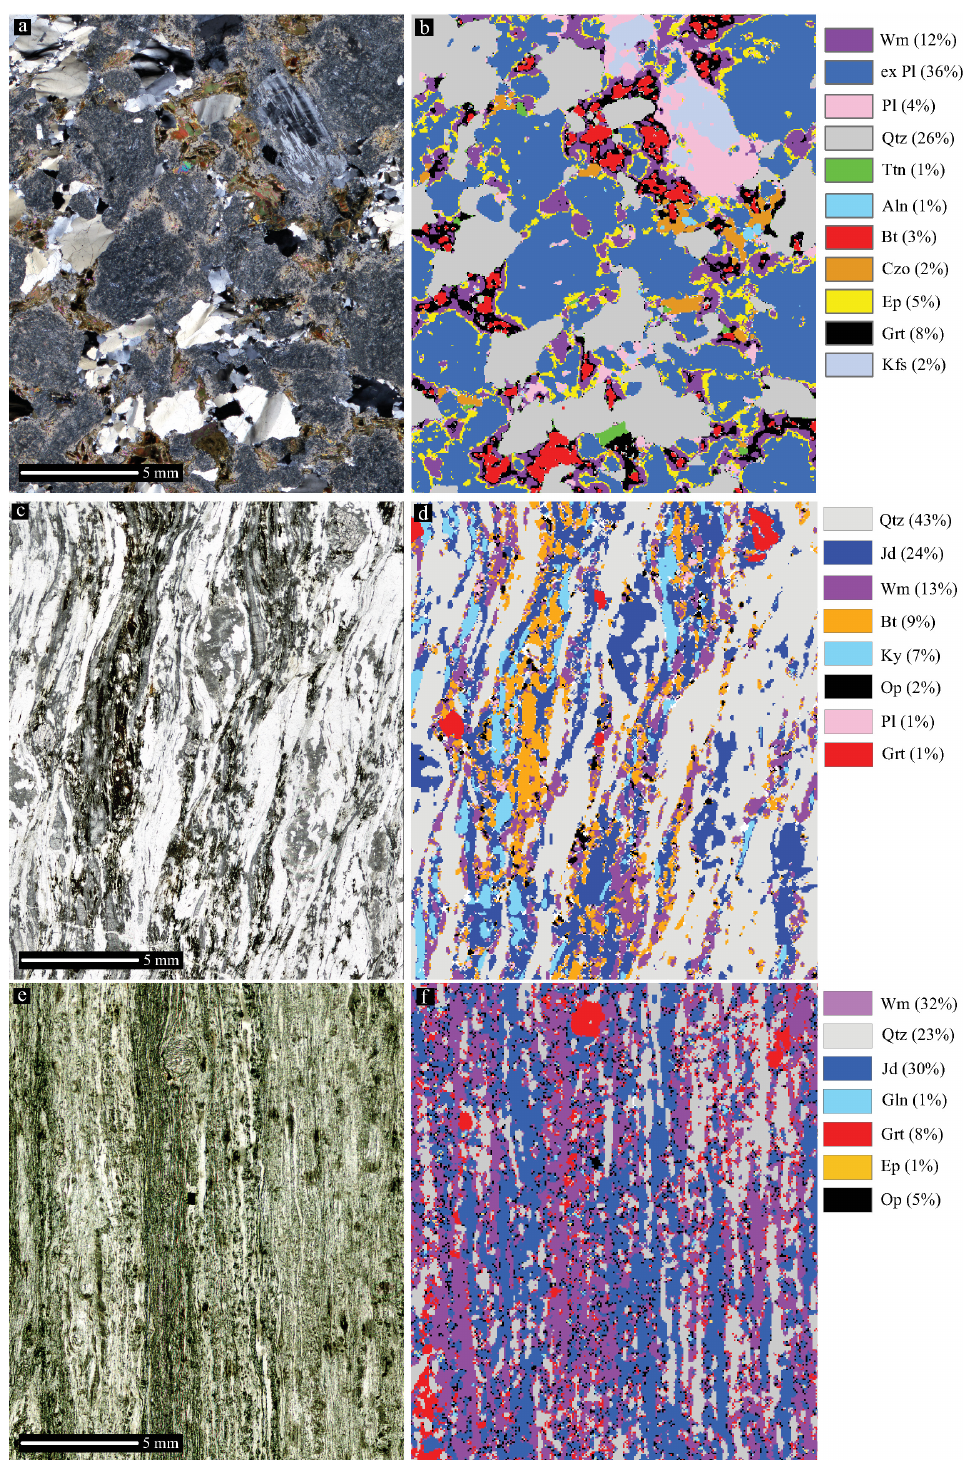
Figure 6. Investigated samples from LdV, MM, and RCT localities at the thin section scale: ( a , c , e ) optical thin section scans of LdV metagranite (crossed polars), MM metapelite (plane polarised light), and RCT mylonitic paragneiss (plane polarised light); ( b , d , f ) LdV, MM, and RCT mineral distribution maps and relative modal abundances obtained through the first cycle of the